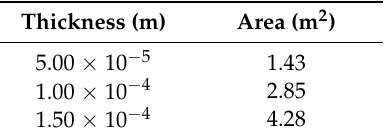
Table 3. Permeation area required for different thicknesses of the membrane tubes at 623